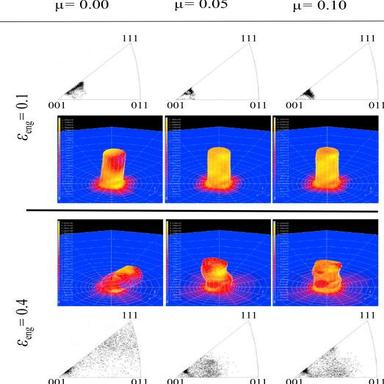
Crystal Plasticity (CP) simulation of Copper pillar compression: Pillar geometry and corresponding crystallographic orientation distribution at an engineering strain of 0.1 (top) and 0.4 (bottom) with different friction coefficients (from left column to right, 0.00, 0.05, and 0.10). Color code: equivalent VON MISES stress from blue (low values) to yellow (high values). Figure adopted from with permission from Elsevier. (For interpretation of the references to color in this figure, the reader